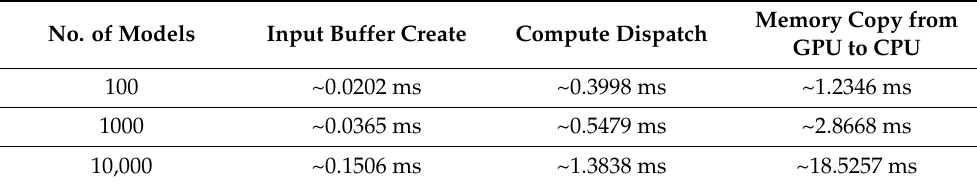
Table 1. Performance figures for compute shaders with various number of elements. Performance is subject to variations based on hardware specifications, its power state, operating system, and driver version. All values are averages over 600 samples. Memory copy from GPU to CPU also involves converting raw bytes to the data structures describing model state, which is why it is slightly slower and consumes the better part of the GPU